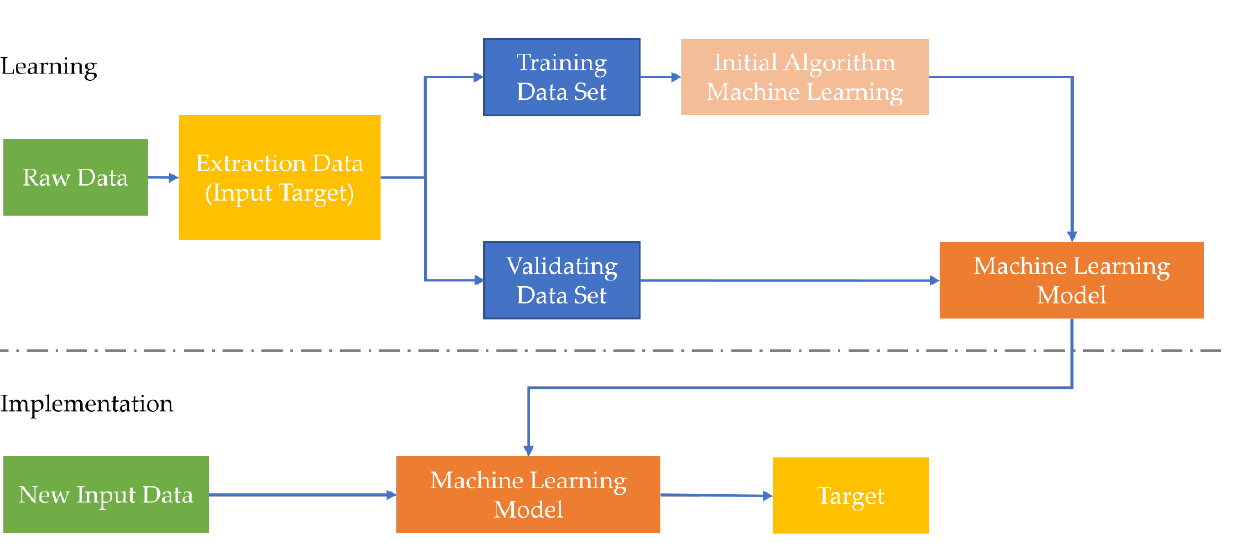
Figure 3. Machine learning (ML) flowchart.